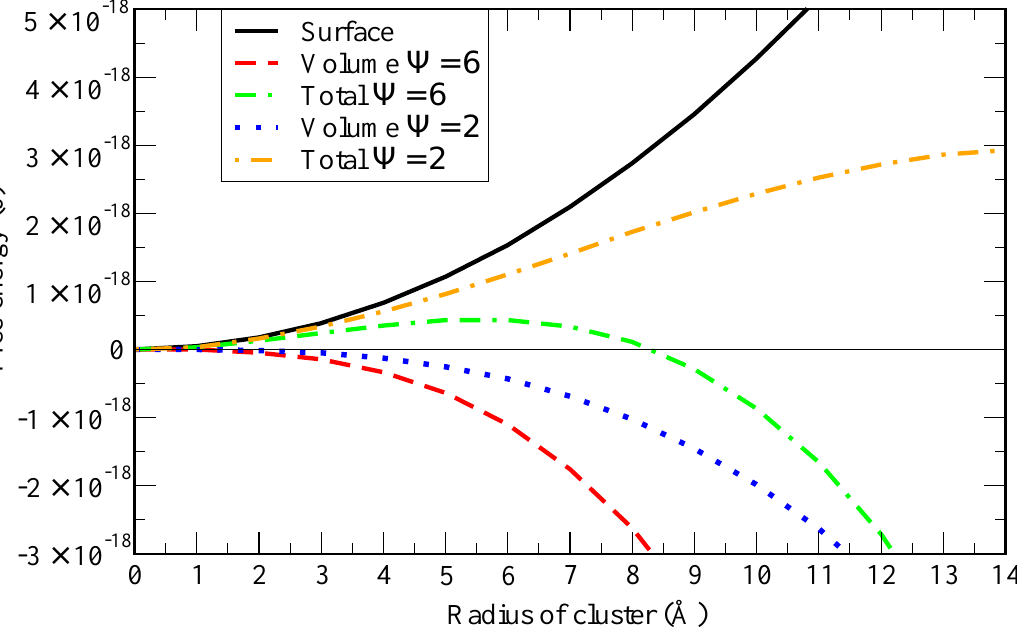
Figure 1. Free energy of a He cluster forming in lithium at 843 K assuming a surface tension of 0.34 N/m [15]. Using a volume of 17 Å 3 for helium [12], the critical size is 42 atoms when supersaturation ratio ψ = 6 and 110 atoms when ψ = 2, where ψ is defined as the ratio between the actual helium concentration and the saturated